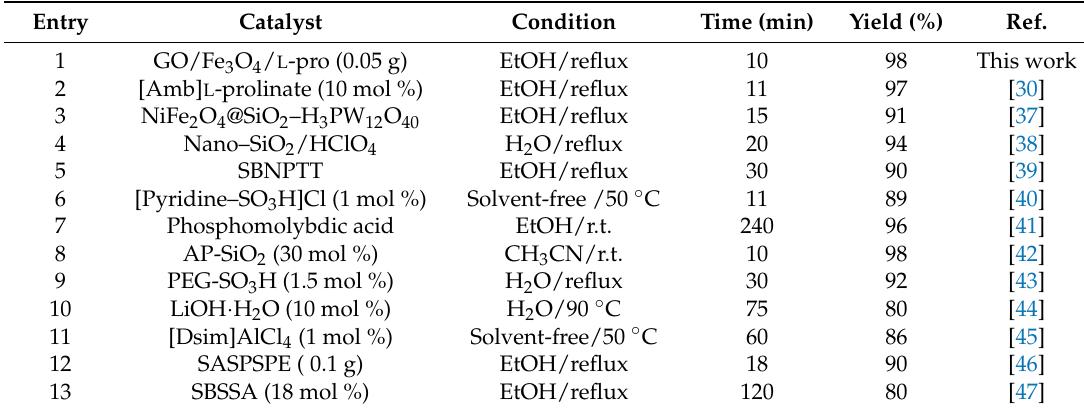
Table 4. Comparison of the catalytic efficiency of GO/Fe 3 O 4 / L -pro with various catalysts reported for the synthesis of 3a